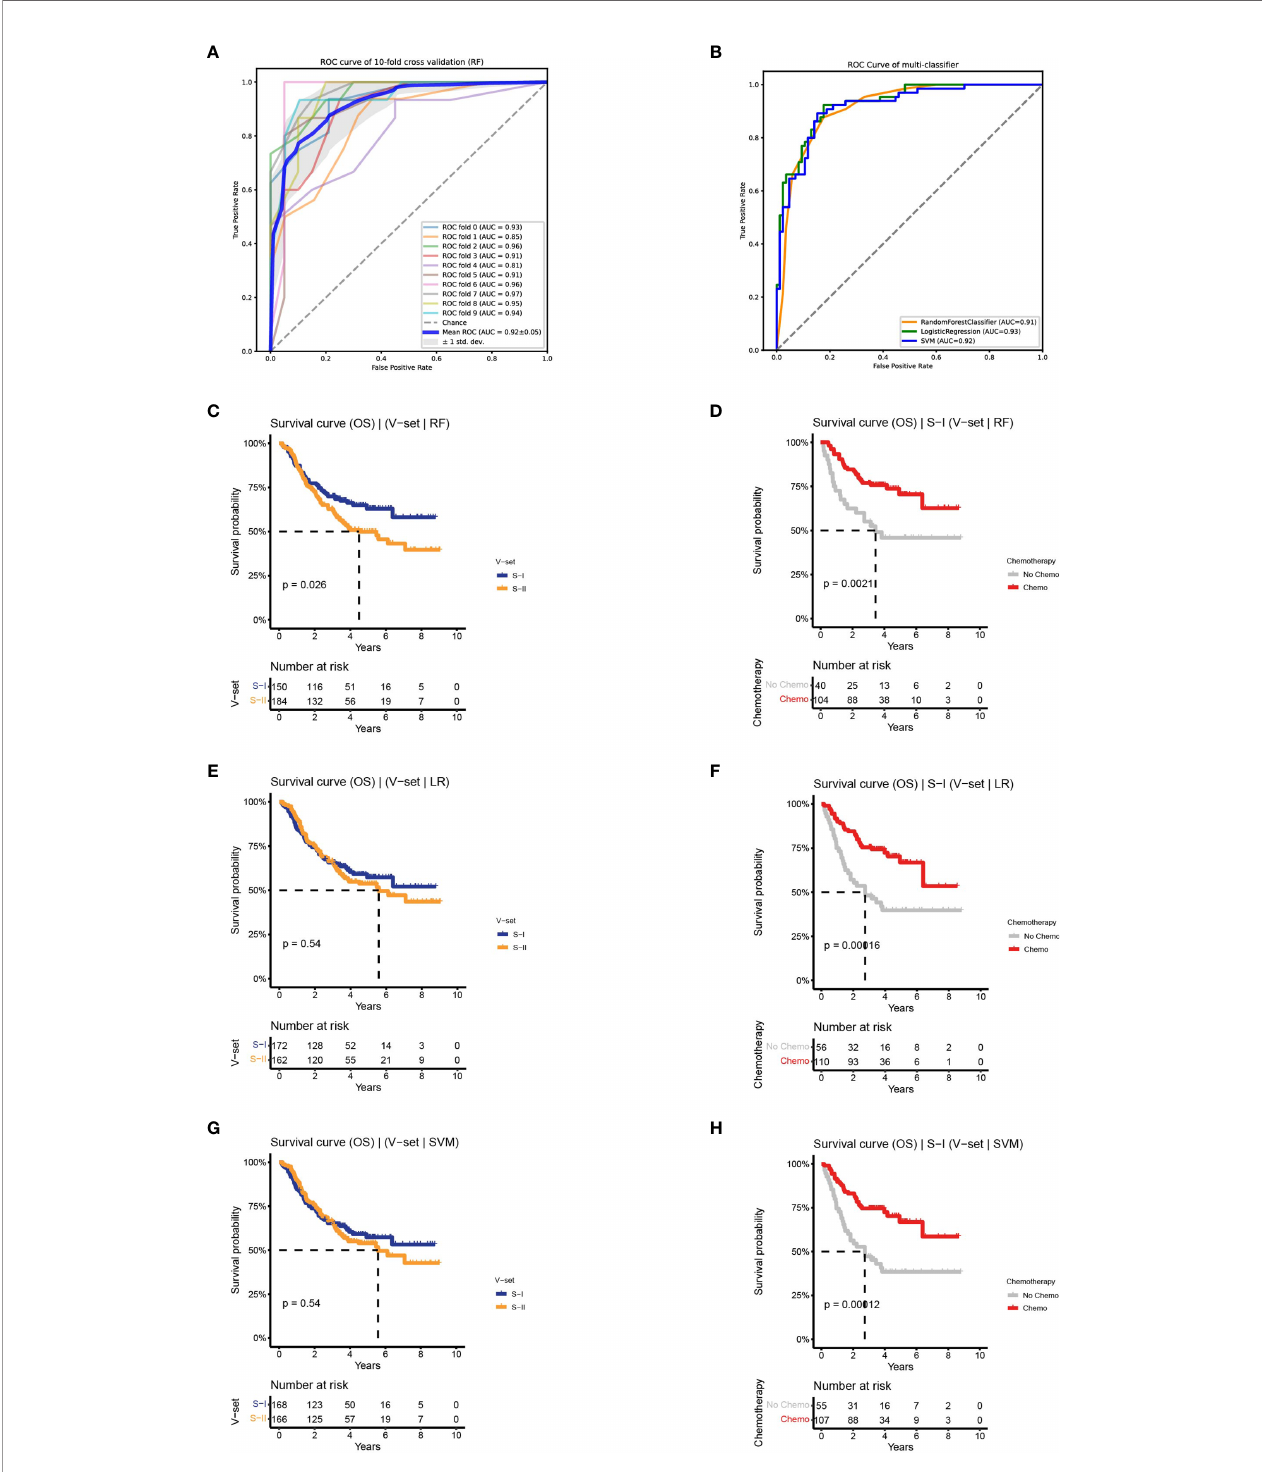
FIGURE 3 | Classi fi ers were established to predict survival-risk labels for samples in the independent set. (A) The receiver operating characteristic (ROC) curve of RF on training set with 10-fold CV. (B) The ROC curve of three classi fi ers on test set. (C, D) The Kaplan – Meier (K – M) curves of the subtypes in independent set predict by RF: OS (left) and OS by chemotherapy status of S-I (right). (E, F) The K – M curves of the subtypes in independent set predict by LR: OS (left) and OS by chemotherapy status of S-I (right). (G, H) The K – M curves of the subtypes in independent set predict by SVM: OS (left) and OS by chemotherapy status of S-I